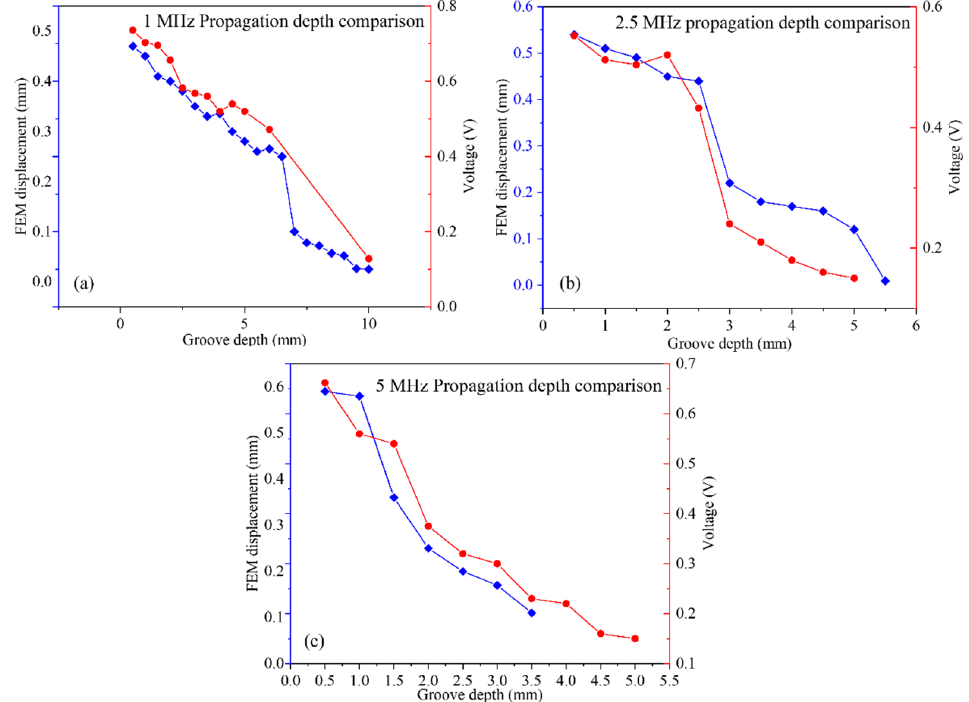
Figure 10. Comparison of longitudinal critically refracted wave signal amplitude with simulation amplitudes at different frequencies: ( a ) 1 MHz signal simulation and experimental comparison; ( b ) 2.5 MHz signal simulation and experimental comparison; ( c ) 5 MHz s ignal simulation and experi- mental comparison.